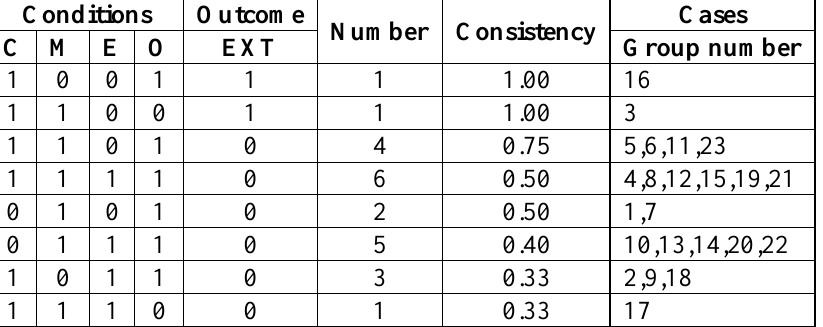
Table A3.2. Truth table of csQCA for the analysis of sufficiency for the group success. L=Leader, K=Knowledge generator, C=Connector, F=Follower, M=Moralist, E=Enforcer, O=Observer.